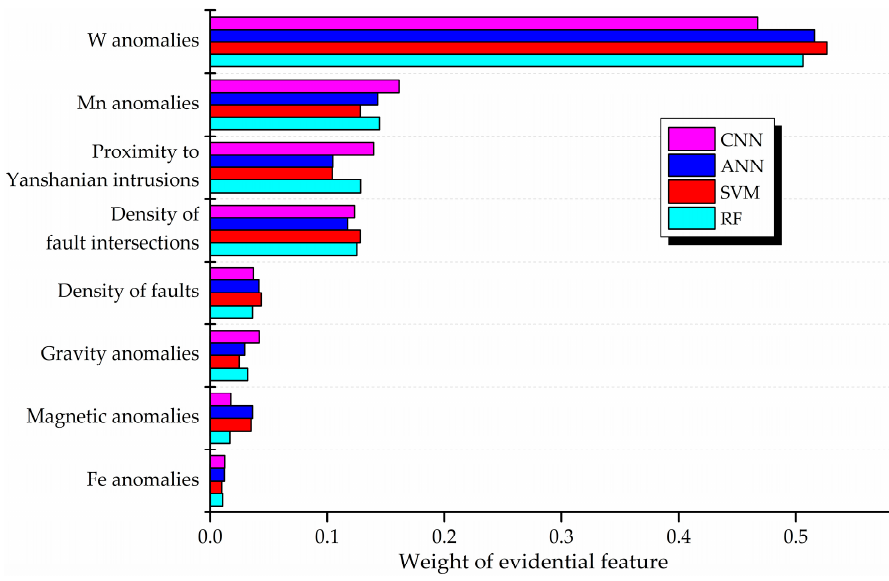
Figure 14. Weights obtained by information gain indicating the contribution of each evidential feature to